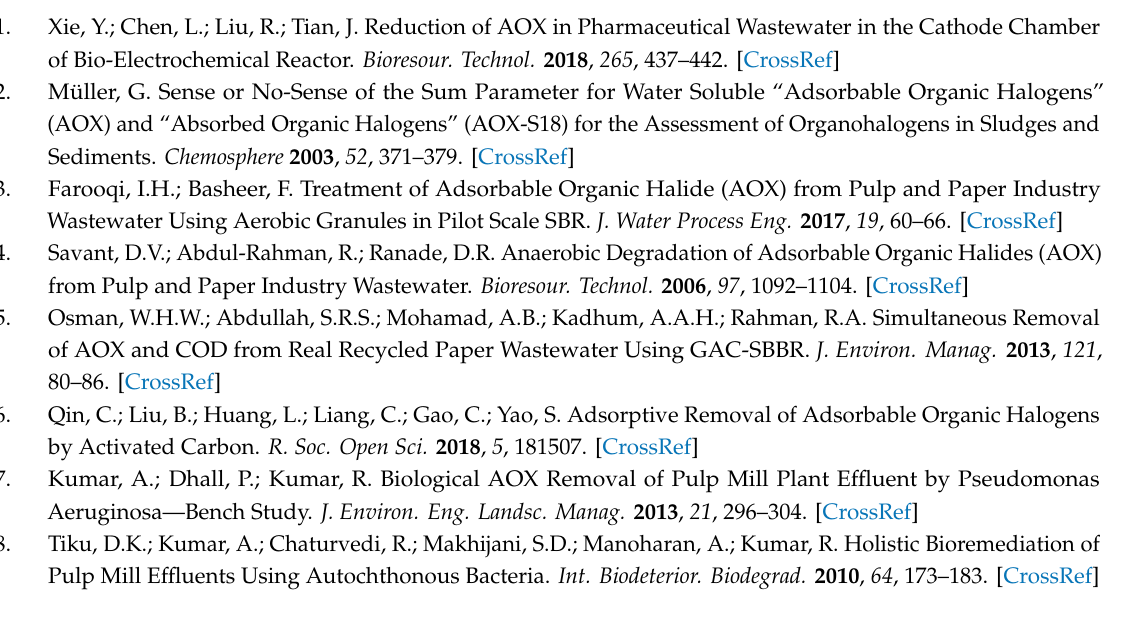
Table S1: Used dataset, Figure S1: Visualization of cross validation error for the prediction of the total AOX concentration, Figure S2: Visualization of cross validation error for the prediction of the soluble AOX